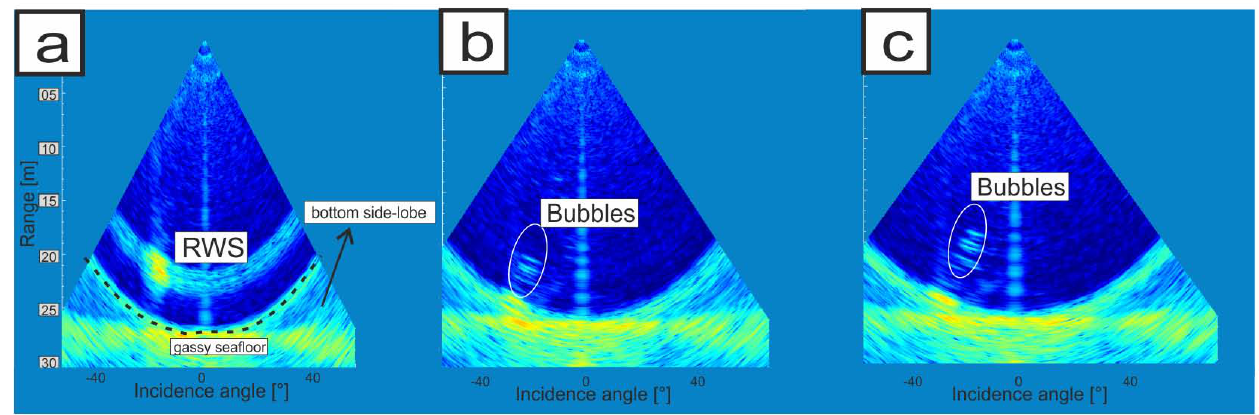
Fig. 2. Color-coded raw backscatter images recorded by the multibeam echo sounder showing background water column reflections (dark blue), center beam artifacts and semi-circular side-lobe-interference close to the seafloor (light blue). (a) The downcast of a rosette-water- sampler (yellowish RWS) is seen. (b) Gas bubble release (yellowish ellipses). (c) Vertically shifted gas bubbles. The swath width x(z) at